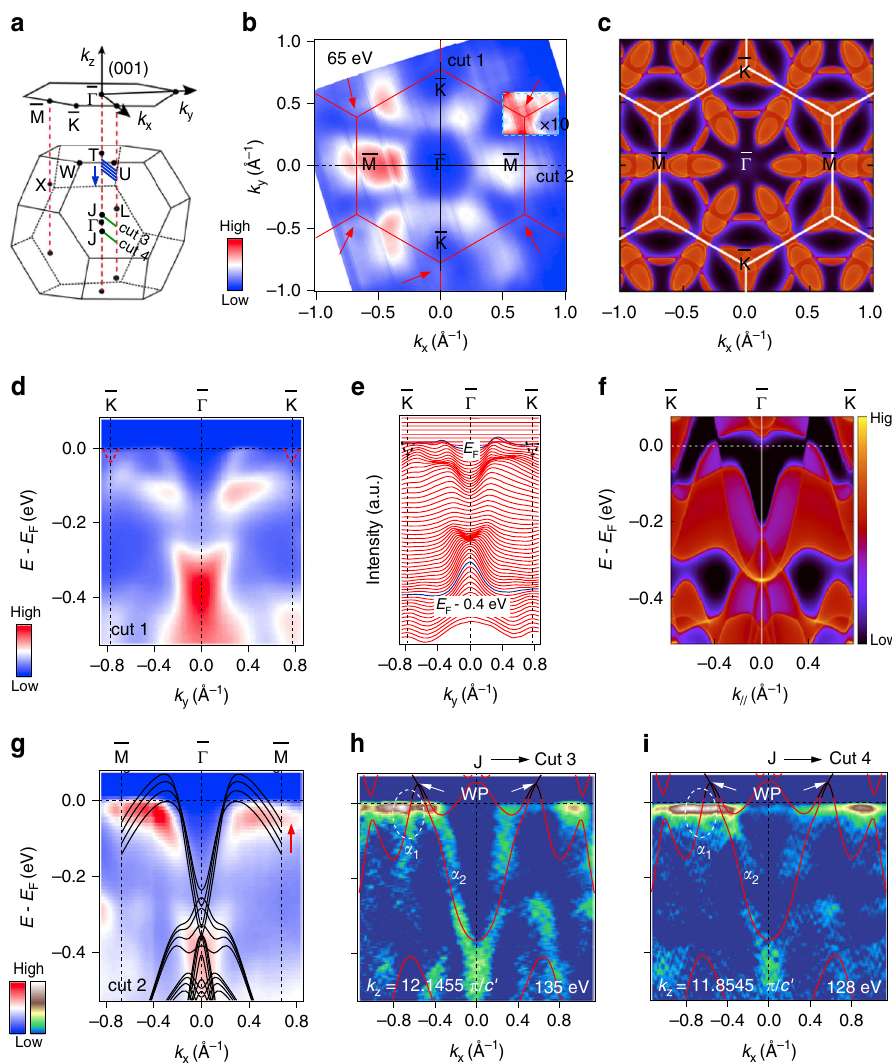
Fig. 3 Near- E F ARPES spectra compared with fi rst-principle calculations of Co 3 Sn 2 S 2 . a Schematic primitive BZ and 2D projected BZ of the (001) surface. Blue lines parallel to the Γ (cid:3) M direction indicate the momentum locations of calculated band structures in g , with the k z momenta of 0.96, 0.92, 0.88, and 0.84 π from top to bottom, respectively. Cuts 3 and 4 illustrate the momentum locations of the predicted WPs, which are parallel to the Γ (cid:3) M direction in the k z = ± 0.1455 π planes. b Constant energy ARPES image obtained by integrating the spectral weight within E F ± 10 meV recorded with 65 eV photons. Cuts 1 and 2 indicate the momentum locations of the experimental band structures in d – i . Red lines represent the (001) surface BZs. Red arrows indicate the triangle-shaped FSs centered at K points in c . The intensity within the cyan dashed rectangle has been multiplied by 10. c Projections of calculated bulk FSs on the (001) surface. White lines represent the (001) surface BZs. d , e ARPES intensity plot and corresponding momentum distribution curves along the K (cid:3) Γ (cid:3) K direction [cut 1 in b ], respectively. Red and black dashed curves illuminate the electron bands forming the triangle-shaped FSs centered at K points. f Projections of calculated bulk bands along the K (cid:3) Γ (cid:3) K direction. g ARPES intensity plot along the M (cid:3) Γ (cid:3) M direction [cut 2 in b ]. Black curves represent the calculated bulk bands along the four directions indicated by blue lines in a , where the bands from bottom to top correspond to the cuts from top to bottom, respectively. h , i Second derivative intensity plots along cuts 3 and 4 recorded at h ν = 135 and 128 eV ( k z = ± 0.1455 π ), respectively, with corresponding bulk calculations (superimposed red curves). The band crossings for WPs are highlighted by black curves. The crossing- E F features of the α 1 bands are marked out by white dashed ellipses